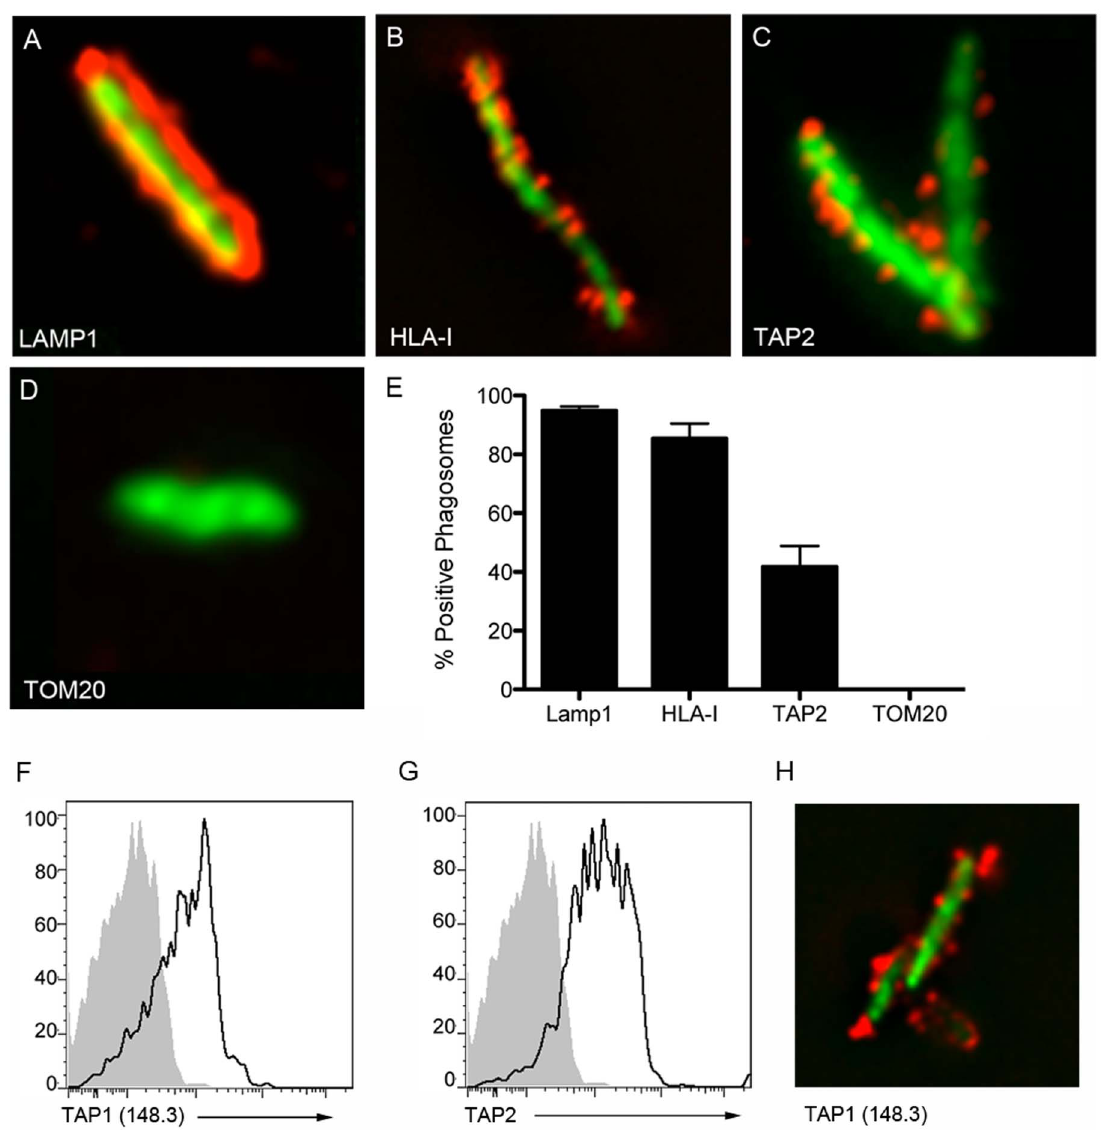
Figure 1. TAP is present in highly pure Mtb phagosomes. Mtb-containing phagosomes were stained with antibodies against A) LAMP1; B) HLA-I; C) TAP2 (2.17); or D) TOM20, a Golgi marker used as a negative control; and imaged on a high-resolution wide field Core DV system. One 0.2 um Z-section is shown. E) Mean and SEM of percentage of positive phagosomes ( . 100 observations) for each marker is shown. F-H) Mtb- containing phagosomes were stained with non-commercial antibodies against TAP1 or TAP2, and analyzed by flow organellometry (F-G) or fluorescence microscopy (H).